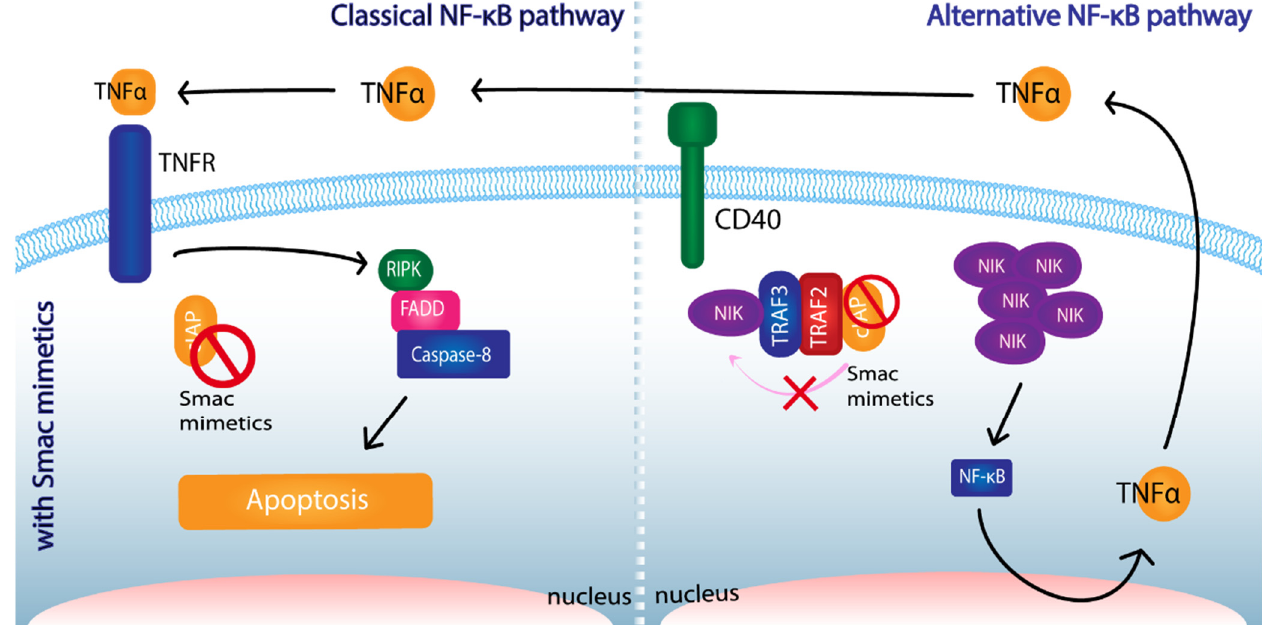
Figure 3. The role of Smac mimetics in the regulation of TNF- α dynamics and the promotion of apoptosis. The inhibition of cIAPs alters NF- κ B pathways. The classical NF- κ B pathway is pushed towards caspase-8 dependent apoptosis through the formation of RIPK-FADD-Caspase-8 complex and it is fed by the production of TNF- α in the alternative pathway. Abbreviations: TNF- α (Tumor Necrosis Factor- α ), TNFR (Tumor Necrosis Factor Receptor), cIAP (cellular- Inhibitor of Apoptosis Protein), RIPK (Receptor-interacting serine/threonine-protein kinase), FADD (Fas-associated protein with death domain), TRAF (TNF receptor associated factor), NIK (NF- κ B-inducing kinase), NF- κ B (nuclear factor kappa-light-chain-enhancer of activated B cells).